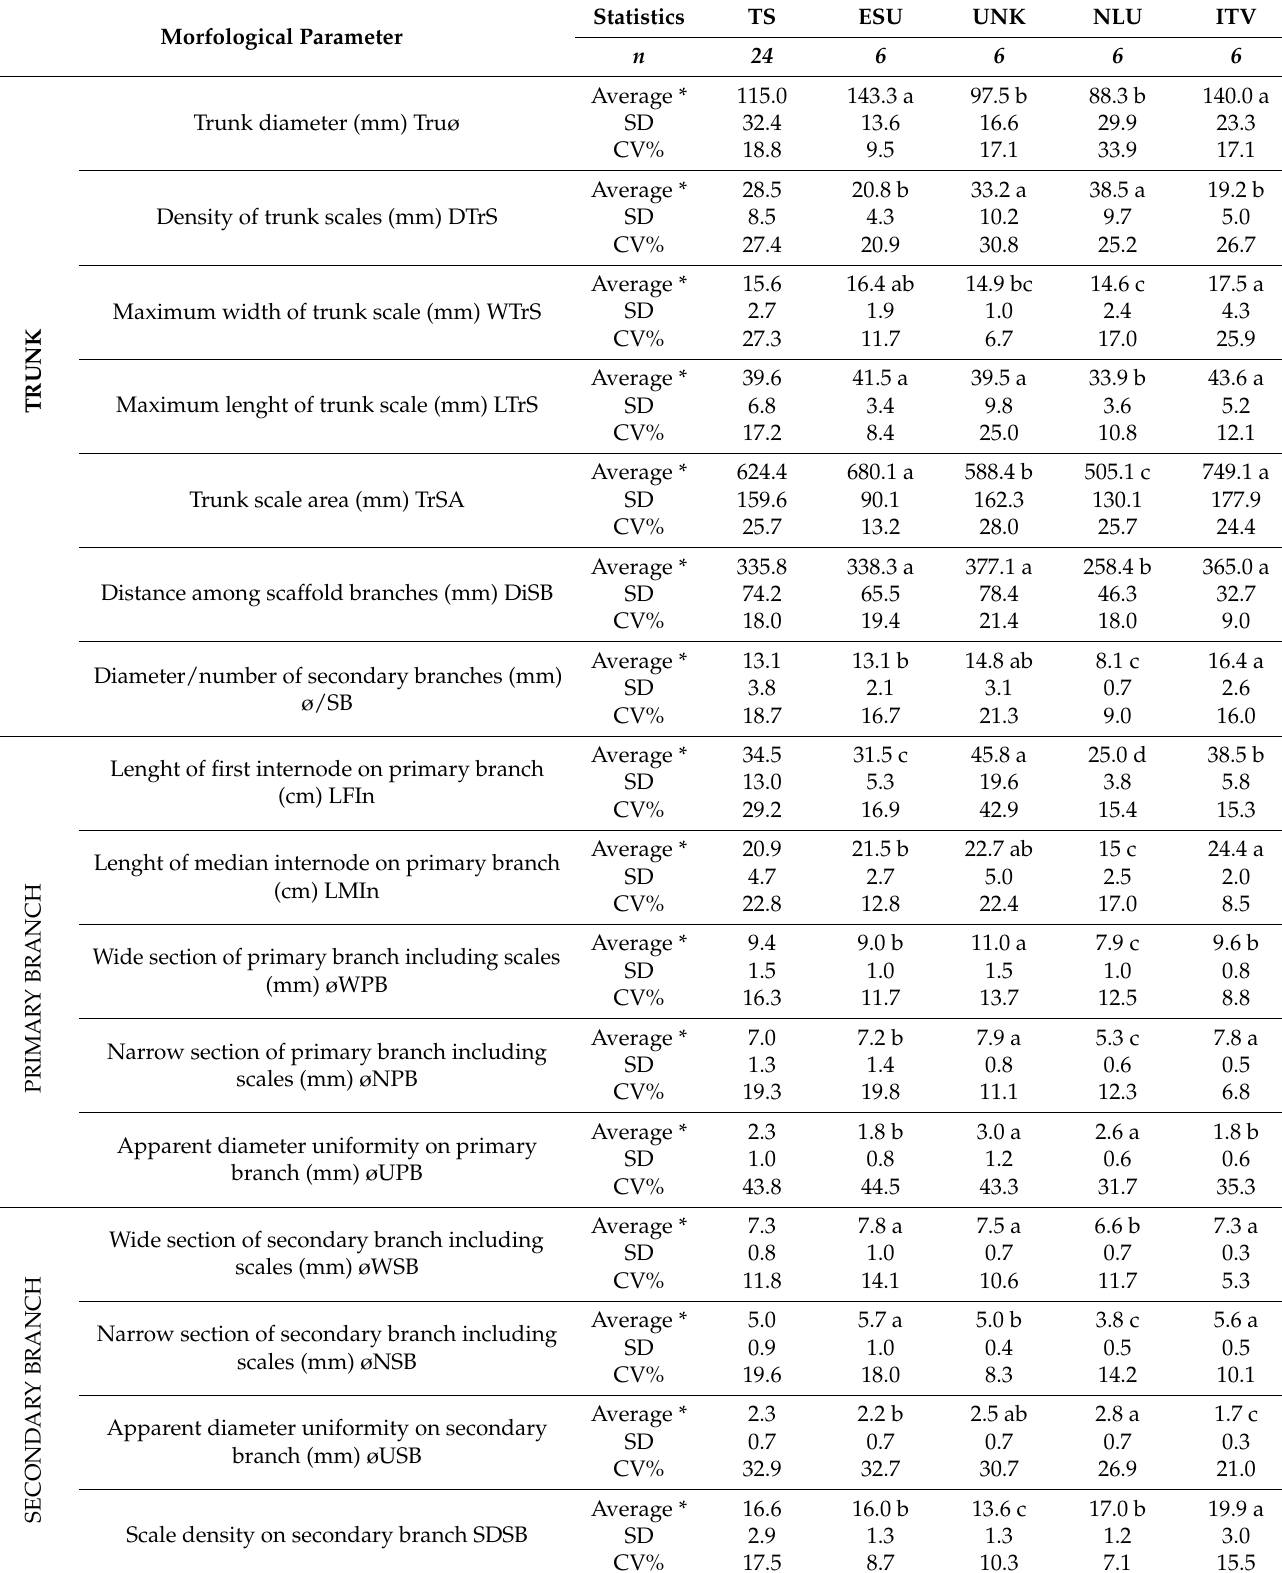
Table 3. Descriptive statistics of morphological parameters of A. araucana related to the total amount of studied specimens (TS) and the four putative populations (ESU, UNK, NLU, ITV). Morfological